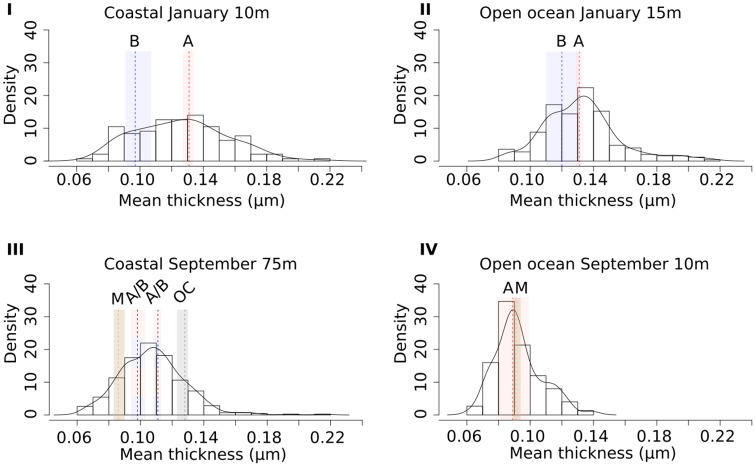
Histograms of coccolith mean thickness measured at each site.The height of the bars represent the relative frequency of the bin (density). The black curve shows the density distribution for coccolith thickness in each sample. Coloured vertical bars represent the 68% credible interval for the MCMC-sampled mean coccolith thickness for each morphotype, while the vertical stapled line represent the median sampled mean value. Red bars/lines: Type A. Blue bars/lines: Group B. Grey bar/line: “Overcalcified” Type A. Brown bars/lines: malformed coccoliths.